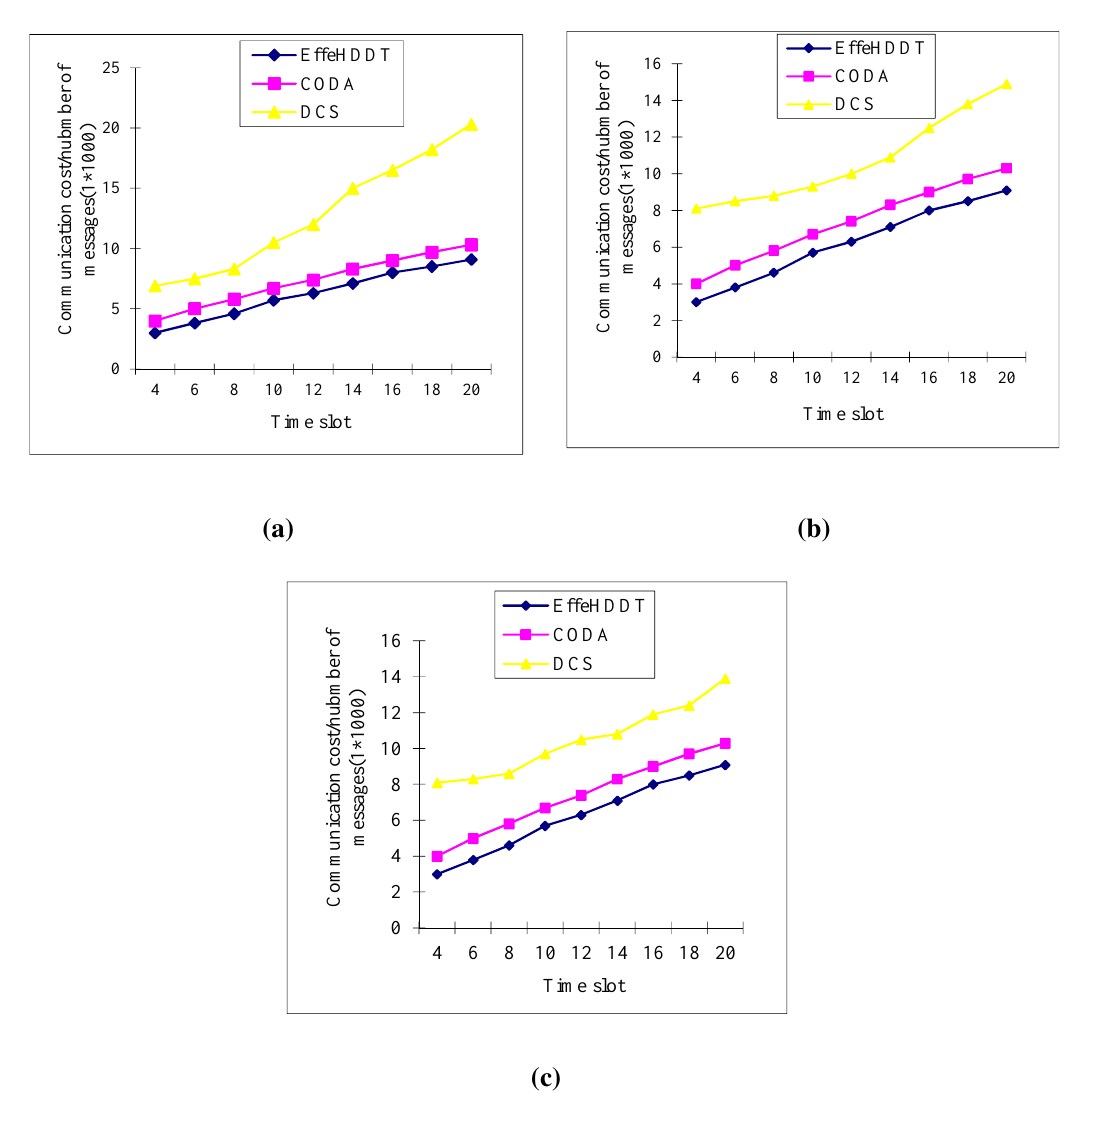
Communication costs over time (EffeHDDT with 50 domains and CODA (continuous object detection and tracking algorithm) with 50 clusters). ( a ) Dynamic clustering scheme (DCS) algorithm [18], with 50 boundary sensors; ( b ) DCS with 160 boundary sensors; ( c ) DCS with 220 boundary